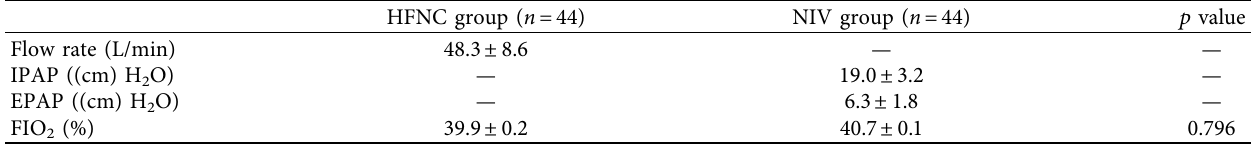
Table 3: Ventilation settings of HFNC and NIV.